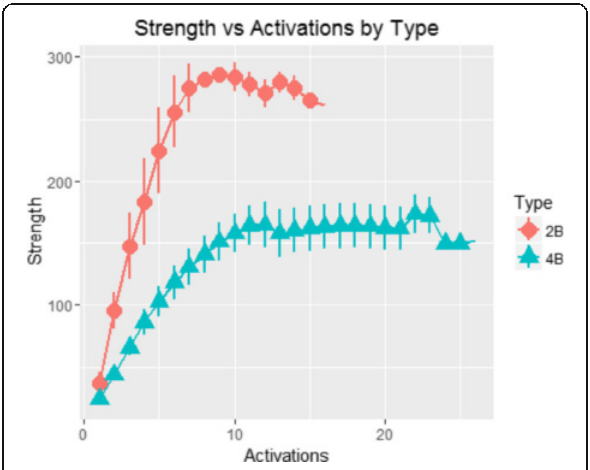
Fig. 6 Comparison of two- and four-arm RPE stiffness